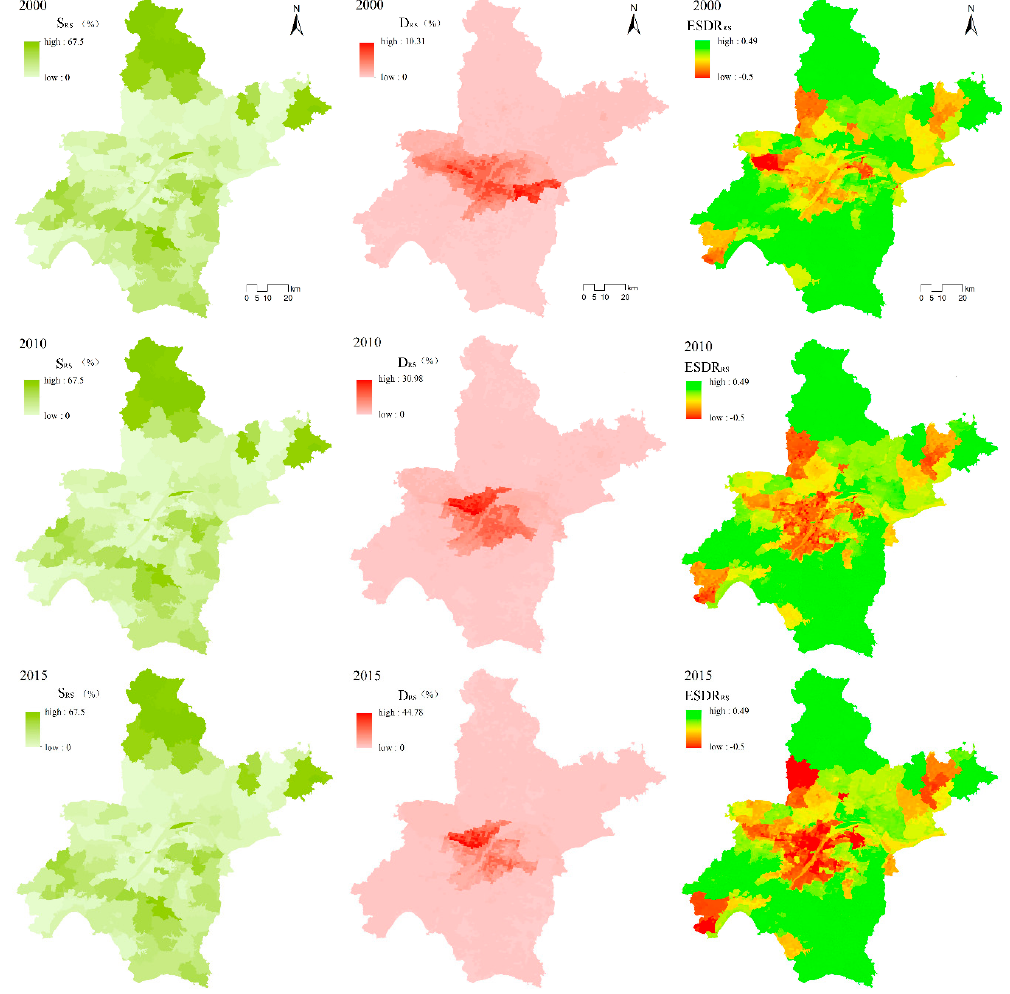
Figure 5. Spatial distribution of supply, demand, and supply–demand ratio of regulation services in Wuhan in 2000, 2010, and 2015.